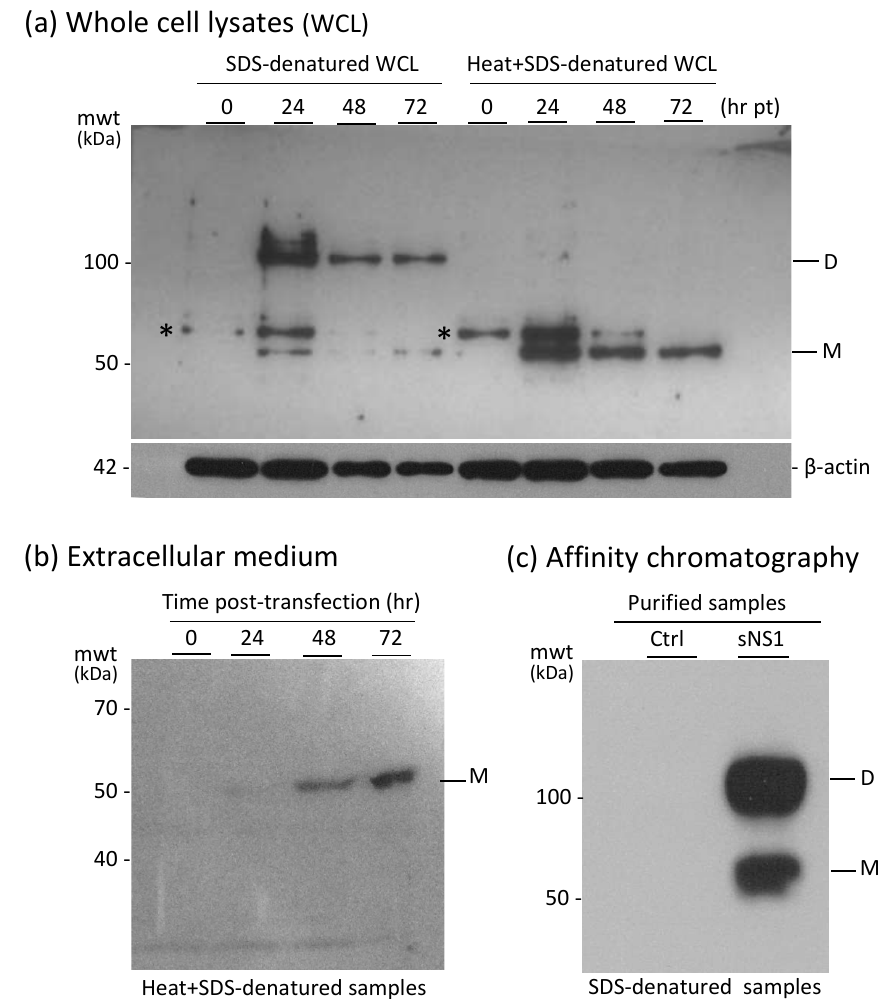
Figure 1. Expression and secretion of the recombinant NS1 WNV protein into the culture medium of pNS1 WNV-IS98 -transfected HEK-293T cells. ( a ) Kinetics of intracellular expression of NS1 WNV . Whole cell lysates (WCL) were denatured in SDS/β-mercaptoethanol-containing loading buffer at room temperature (RT) to preserve the oligomeric status of proteins (leftmost lanes), or subjected to the usual heat denaturation at 95 °C for 5 min in loading buffer (rightmost lanes). Proteins were analyzed by SDS-PAGE and Western blotting. H6-tagged NS1 WNV protein was detected using anti-His6 tag antibody. Note: * = the protein band migrating with an apparent mwt of 58 kDa and visible in both control and NS1-expressing samples might correspond to the superimposition of an anti-His6-tag antibody-reacting cellular protein and a post-translationally modified form of the NS1 WNV protein. ( b ) Secretion of sNS1 WNV protein. Samples from the culture medium of pNS1 WNV-98 -transfected cells were collected at the indicated times post-transfection (pt), heat-denatured in SDS/β-mercaptoethanol- containing loading buffer, and analyzed by SDS-PAGE and Western blotting. ( c ) Purification and oligomeric status of sNS1 WNV . Extracellular H6-tagged sNS1 WNV , isolated by affinity chromatography